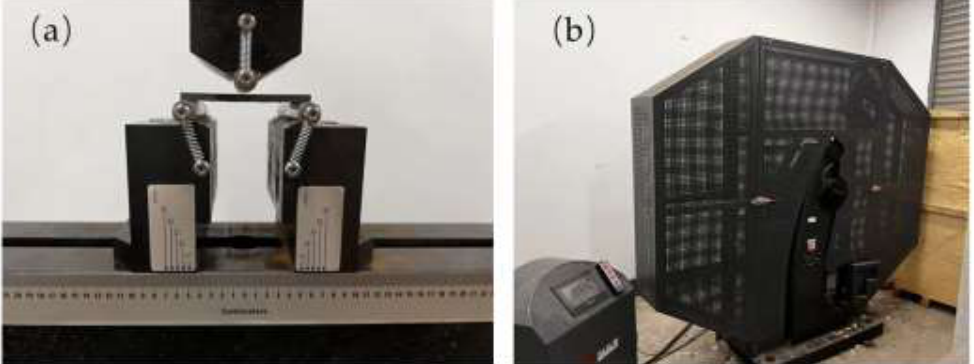
Figure 5. ( a ) Testing bending performance with the universal testing machine; ( b ) pendulum impact Figure 5. (a) Testing bending performance with the universal testing machine; (b) pendulum impact tester testing impact tester testing impact performance